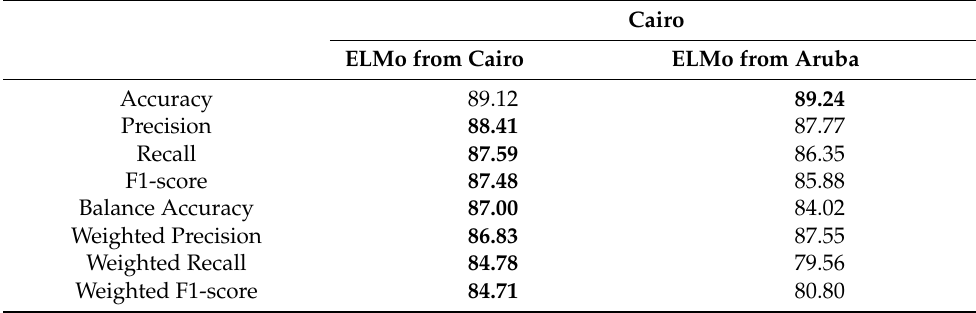
Table 9. Comparison between ELMo trained on the Cairo dataset and ELMo trained on the Aruba dataset, applied on the Cairo dataset (Bidirectional LSTM